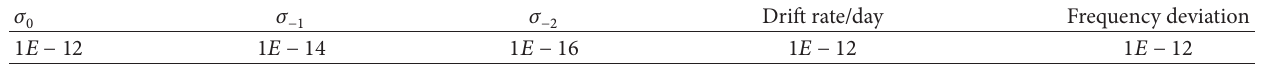
Table 11: Parameters of generated phase